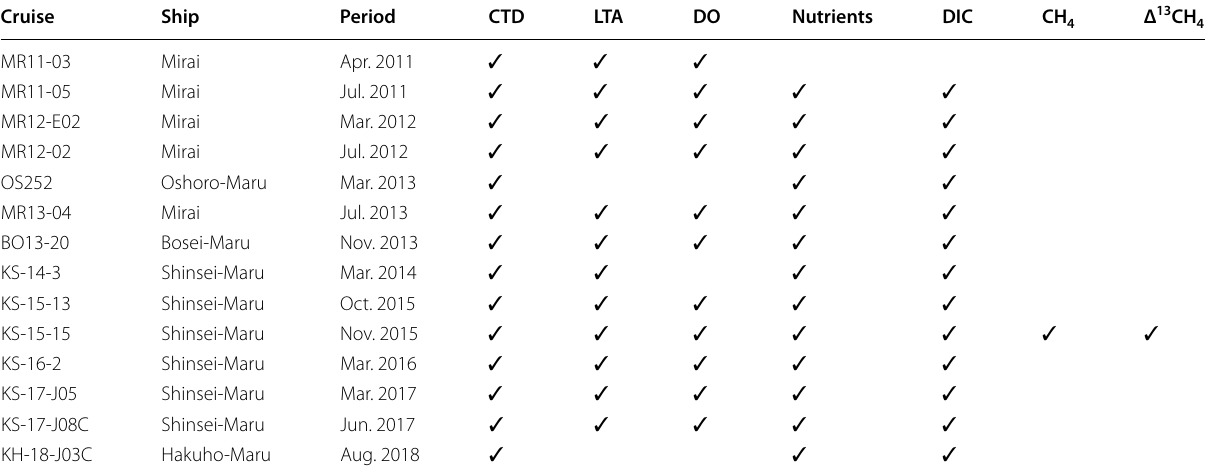
Table 1 Our ship-based hydrographic observations and water sample measurements conducted after the 2011 Tohoku Earthquake Cruise Ship Period CTD